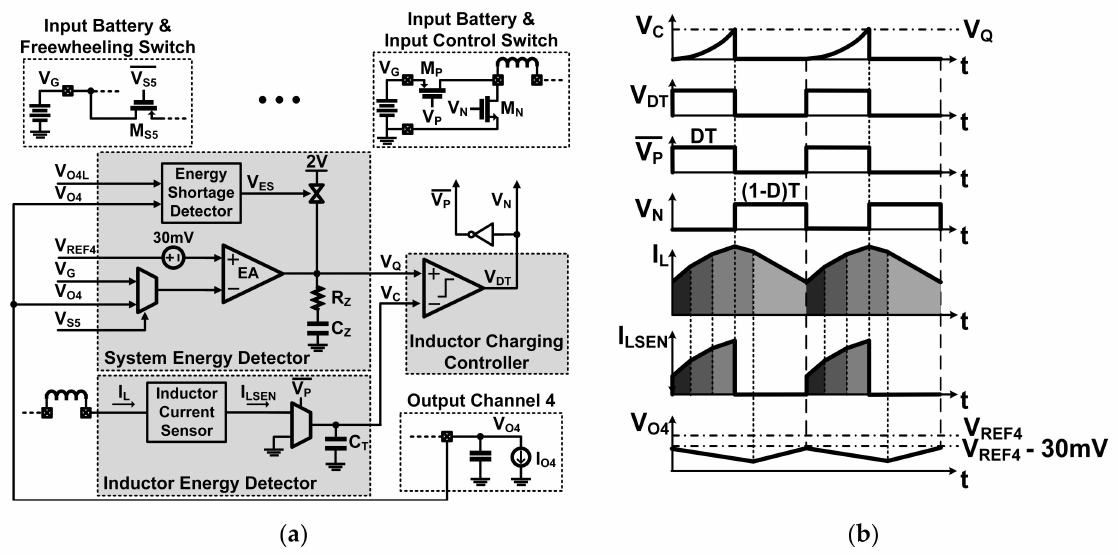
Figure 5. ( a ) Charge control loop for the hybrid converter and ( b ) its timing diagram at steady state.